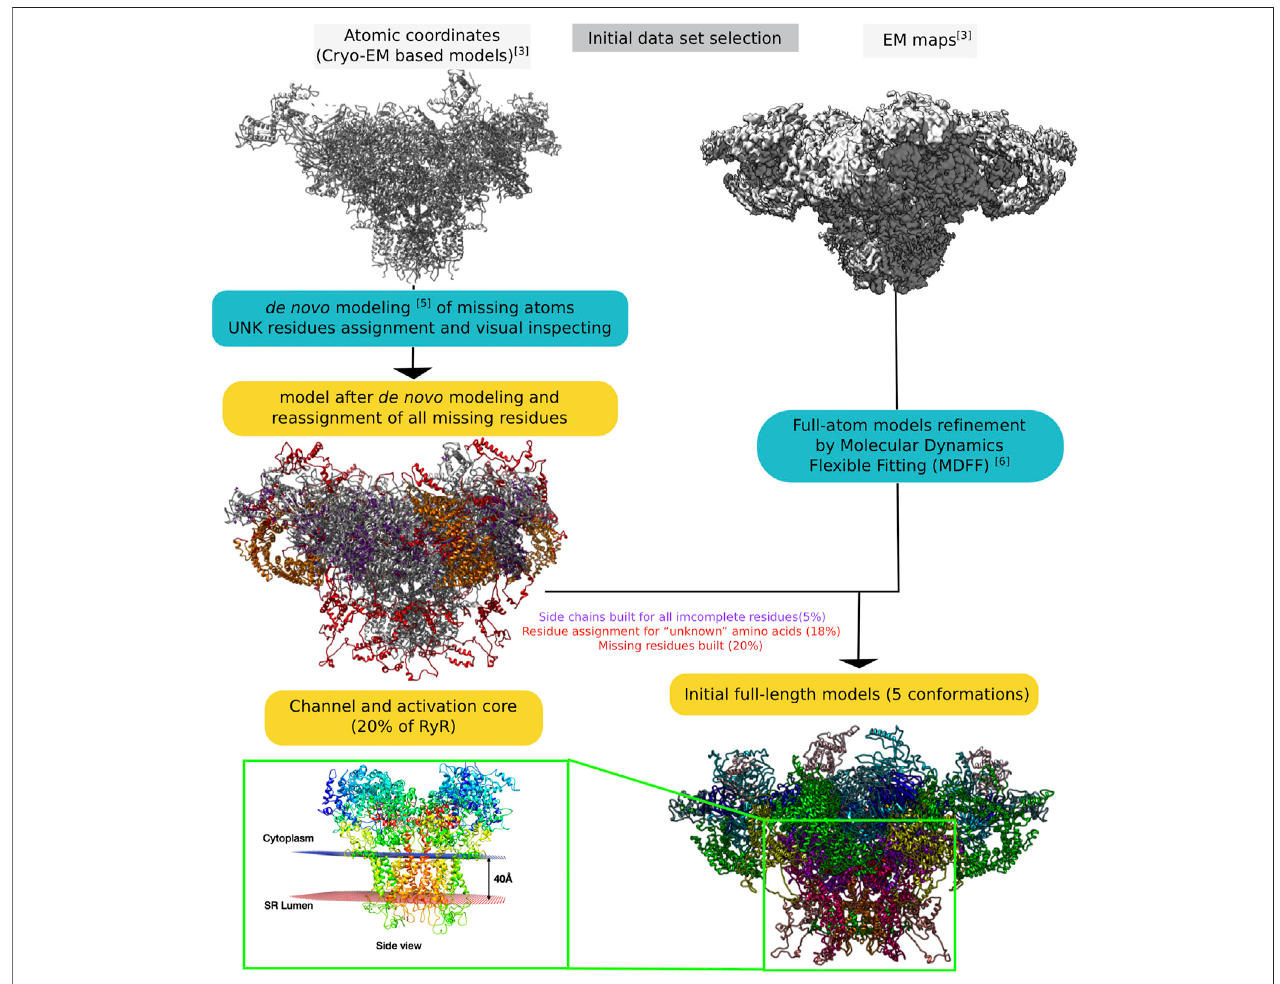
FIGURE 2 | Schematic representation of the entire process of reconstructing the RyR1 model from raw electron microscopy maps to full-length whole-atom models.